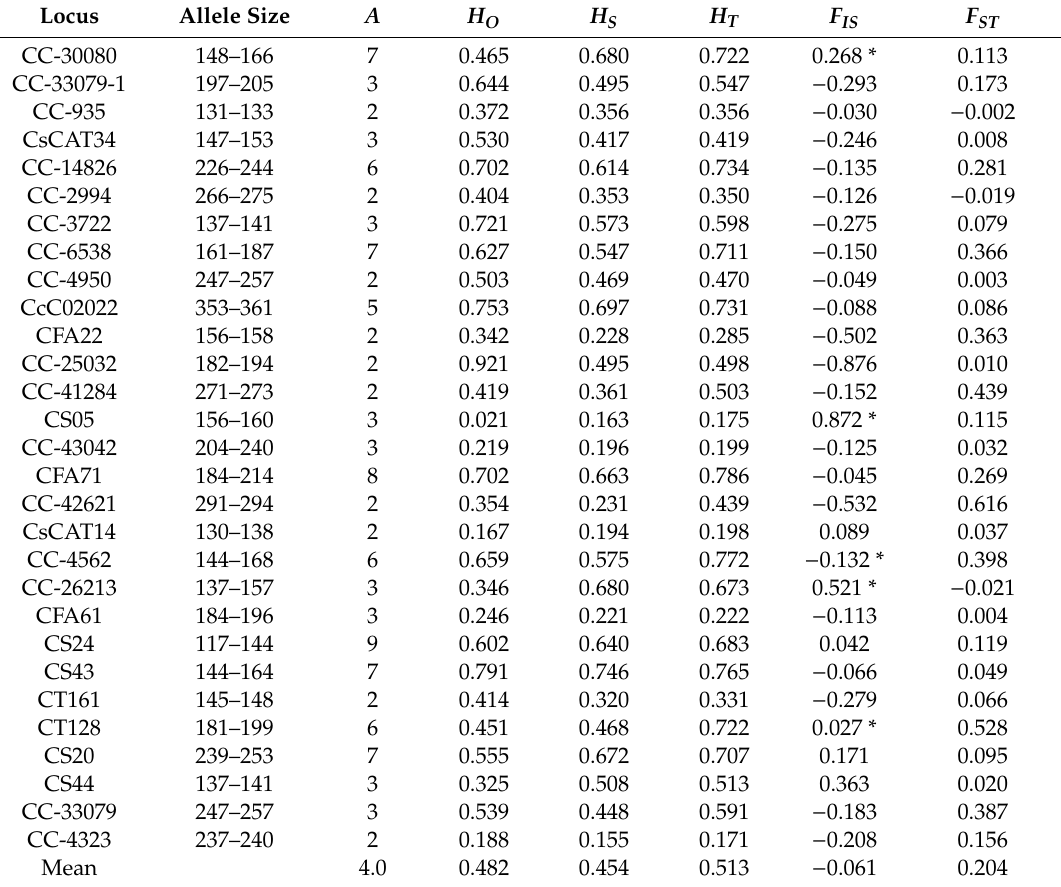
Table 4. Genetic diversity at 29 nuclear microsatellite loci in Castanopsis tibetana .